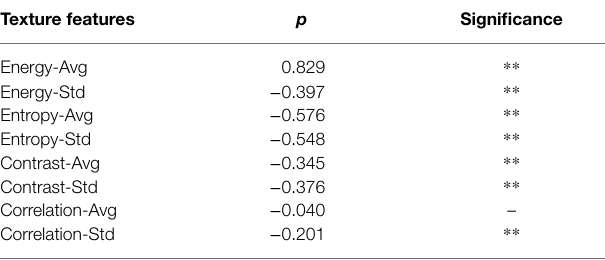
TABLE 6 | Results of the Pearson correlation